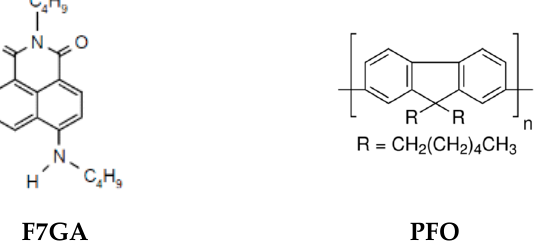
Figure 1. The chemical structures of poly(9,9 ′ -di- n -octylfluorenyl-2,7-diyl) (PFO) and Fluorol